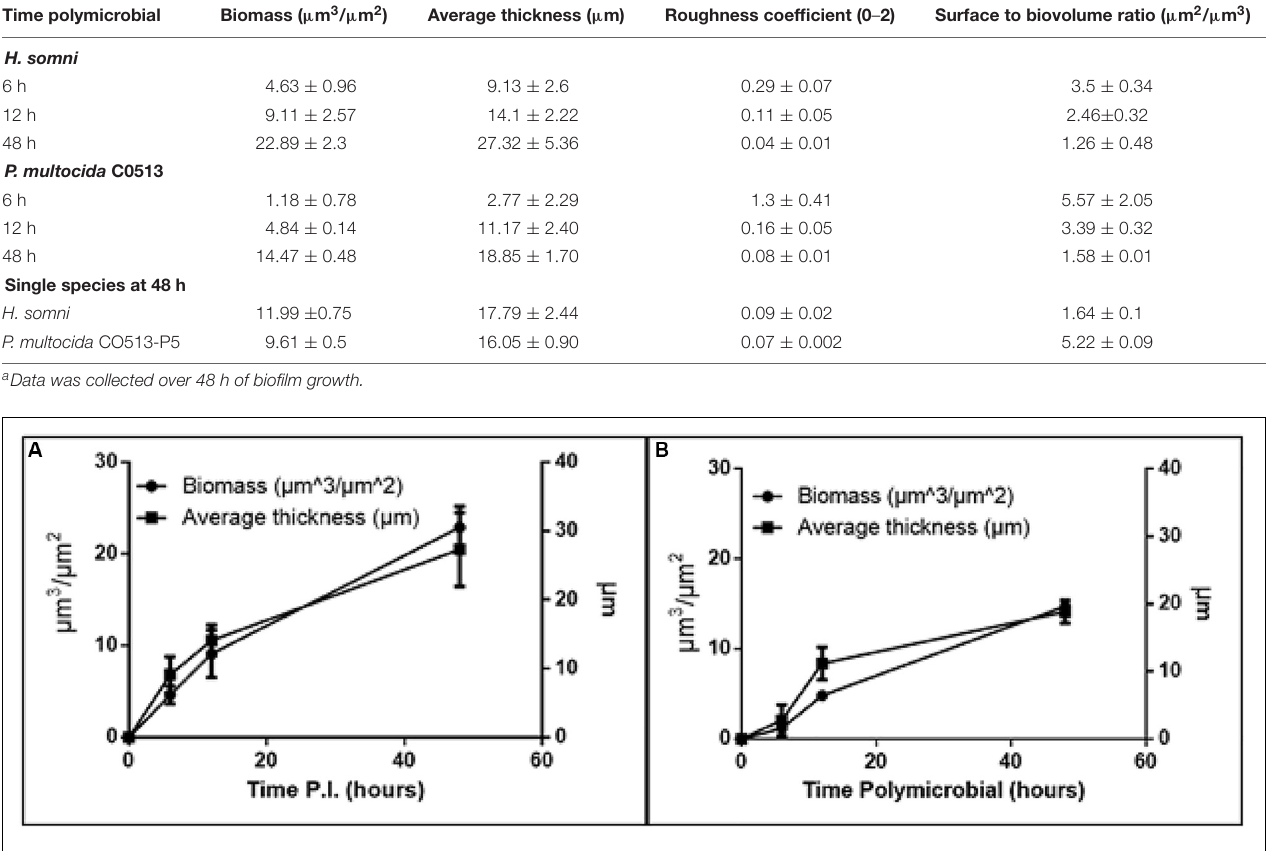
FIGURE 2 | Increase in biomass and thickness within the polymicrobial biofilm. (A) H. somni strain 2336 biomass and thickness within the polymicrobial biofilm. (B) P. multocida strain C0513-P5 biomass and thickness within the polymicrobial biofilm. All experiments were performed in triplicate in three different experiments (9 datum points